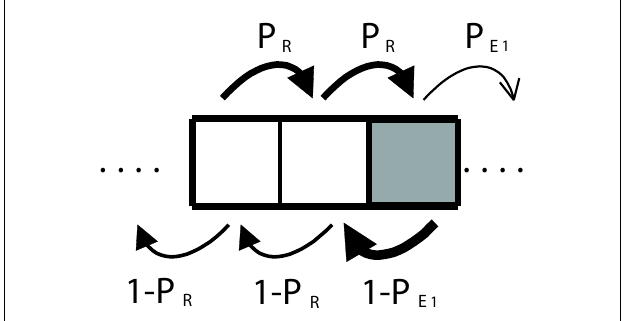
FIGURE 5 | Discrete-time Markov chain corresponding to a three-step sequence. In the white cells, the agent uses the deliberative subsystem and primary emotions in the dark gray ones.